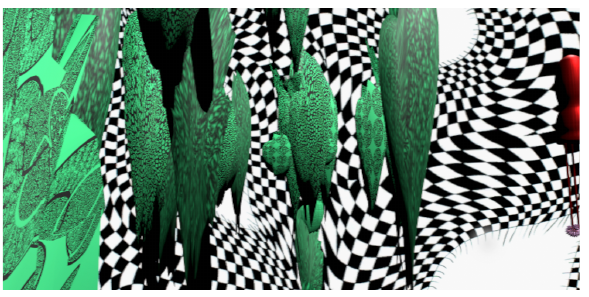
Figure 4. AudioVirtualizer scene 1b